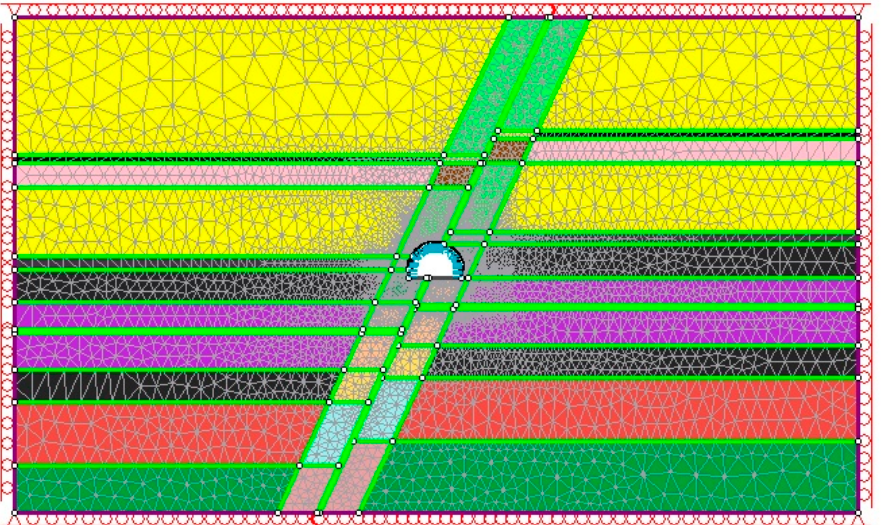
Figure 13. Model planes of the roadway intersecting fault zone.